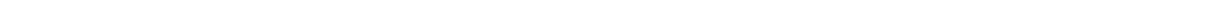
Figure 8 | MondoA and ChREBP knockdown compromise TFEB nuclear localization and target gene expression. ( a ) Representative fluorescent images of TFEB nuclear localization on control, MondoA or ChREBP knockdown in HeLa cells. Starvation-induced TFEB nuclear localization (4h) is impaired by MondoA and ChREBP siRNA knockdown. ( b ) Quantification of TFEB nuclear localization on control or MondoA knockdown. ( c ) Quantification of TFEB nuclear localization on control or ChREBP knockdown. Bars indicate mean ± s.e.m. from four biological replicates. w 2 -test, ** P o 0.01 *** P o 0.001 ( b , c ) ( d ) TFEB target gene expression is affected on MondoA and ChREBP knockdown. The bar represents mean ± s.e.m. from five experiments relative to control siRNA 8-h growth condition. P -value (* P o 0.05 and *** P o 0.001) was determined by one-way analysis of variance (ANOVA) with Tukey’s test relative to control siRNA growth or starvation condition. ( e ) Representative western blotting showing that TFEB knockdown leads to decreased steady-state levels of MondoA and ChREBP. ( f ) A working model based on the current study. MML-1 is upregulated on germline removal. Activated MML-1/MXL-2 represses TOR activity